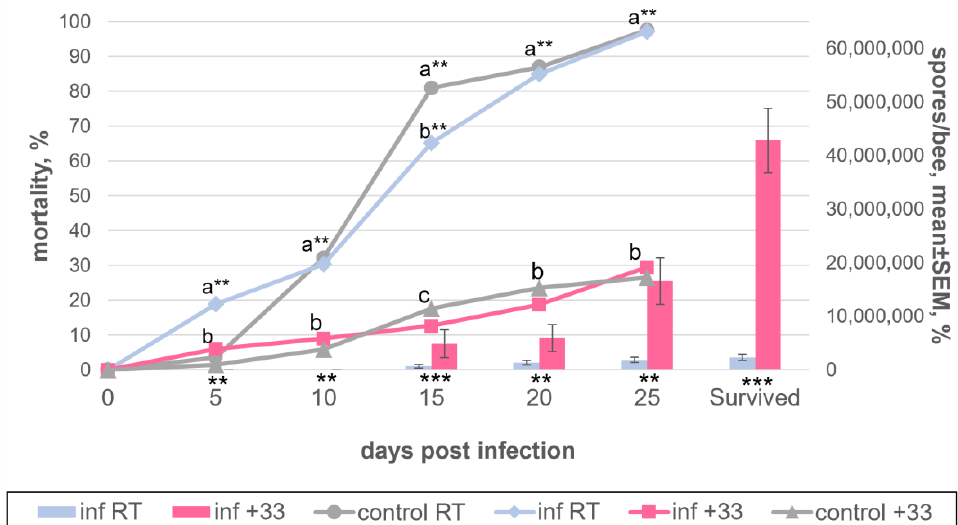
Figure 5. Dynamics of Vairimorpha ceranae development in honey bee adults, maintained either at +25 °C (“RT”) or at +33 °C (“+33”) and experimentally infected with 1 million spores/bee (“inf”). Spores were isolated from dried honey bee cadavers stored at room temperature. The indications are as in Figure 2. The data which this scheme was created from are found in Table S4.